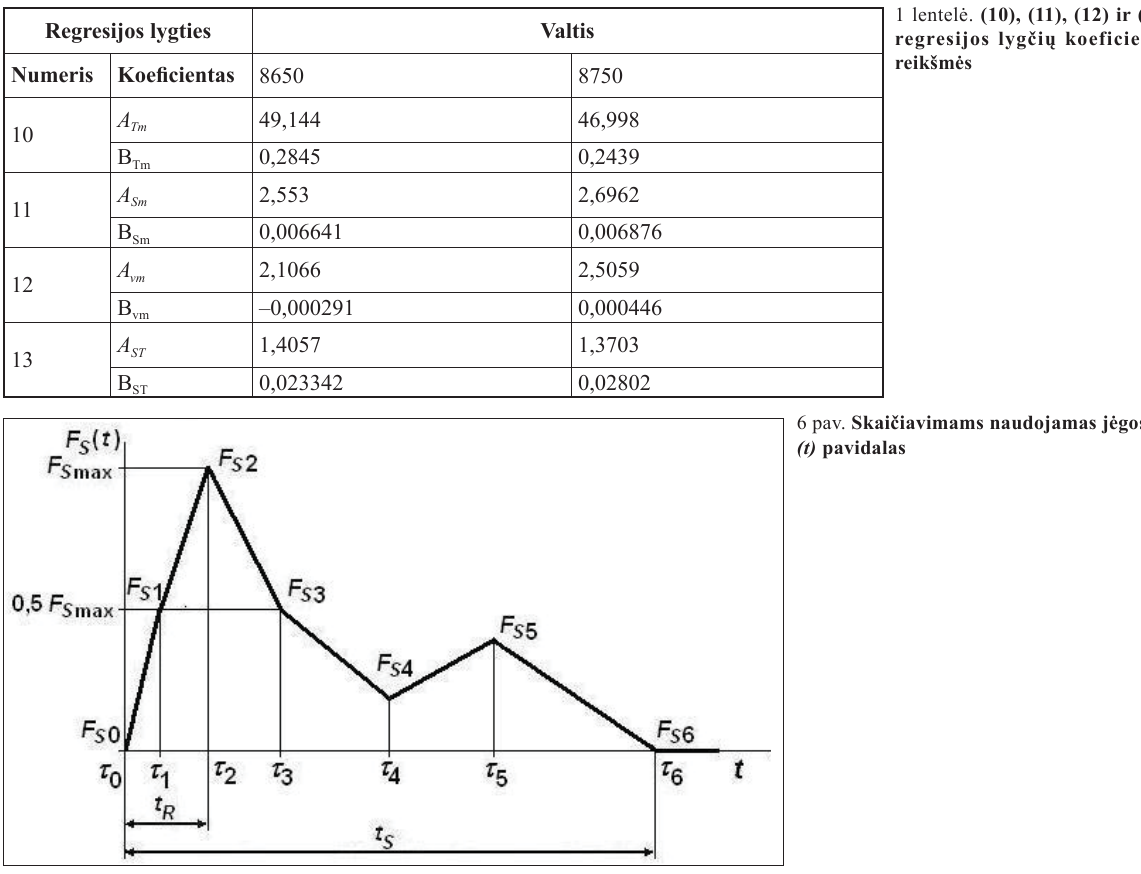
ribose nuo 65 r